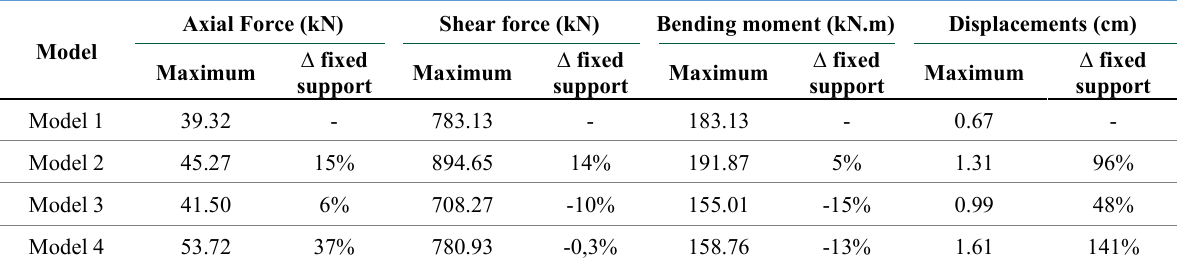
Table 9. Maximum forces on the support beam of wall